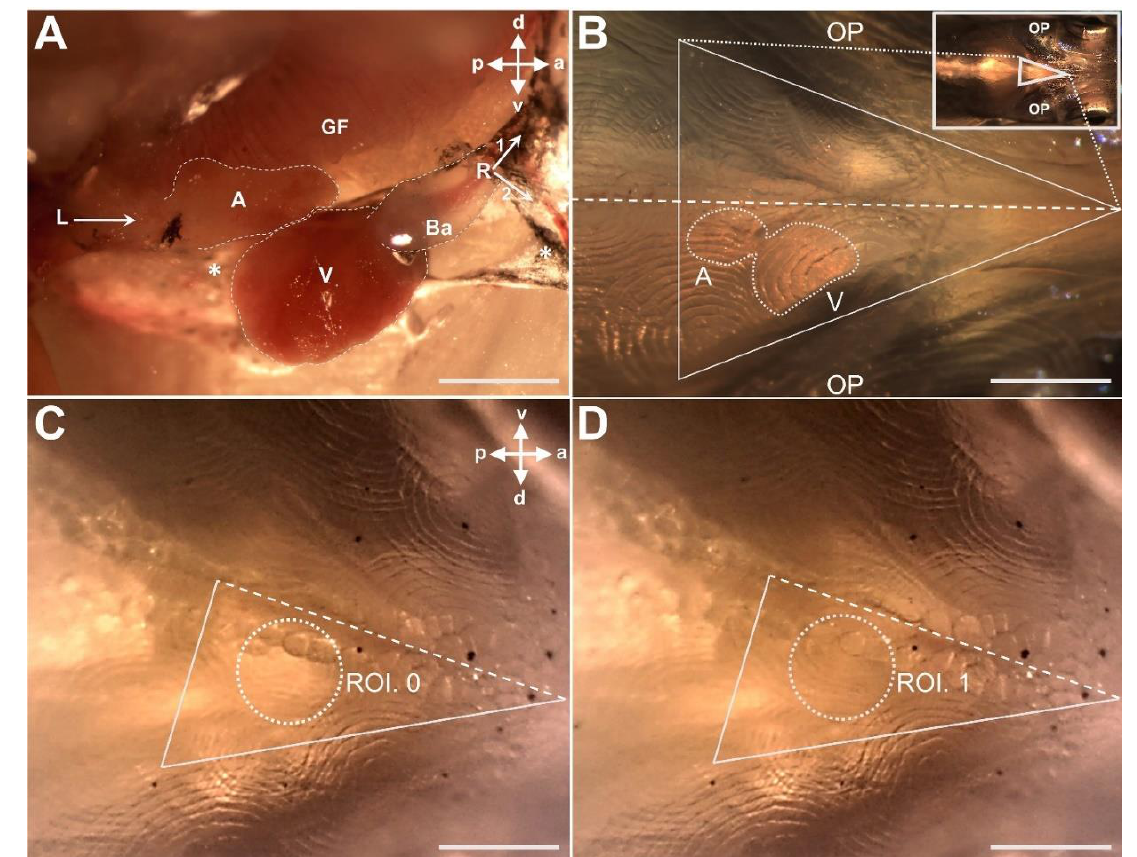
Figure 3. Photographs showing the location and orientation of heart in a dissected ( A ) and live ( B – D ) adult female, Gambusia holbrooki . ( A ) The directions of blood flow into (left arrow) atrium ( A ) and out (right arrows) through bulbous arteriosus (Ba) are shown. The ventricle (V) and epicardium (asterisks) are also marked. Posterior to left and anterior to the right. ( B ) Ventral views of an anaesthetised fish secured in place under a stereomicroscope. The location of the heart and both chambers are shown. ( C , D ) Photographs were directly extracted as time-sequence image stacks from video corresponding to consecutive ventricular diastolic (ROI. 0, brighter) and systolic (ROI. 1, darker) states. The isosceles juxtaposes triangular space between the opercula that can serve as a marker to locate the beating heart in vivo, i.e., to the left of the ventral midline (dashed line) of the fish. ( C , D ) are magnified views of ( B ) in the respective two consecutive image stacks, where the right-angled triangles correspond to the lower half of the isosceles (not to proportion). a, v, p, and d represent anterior, ventral, posterior, and dorsal, respectively. OP = operculum. GF = gill filaments. ( A , B ), scale bar = 1 mm. ( C , D ), scale bar = 500 μm.